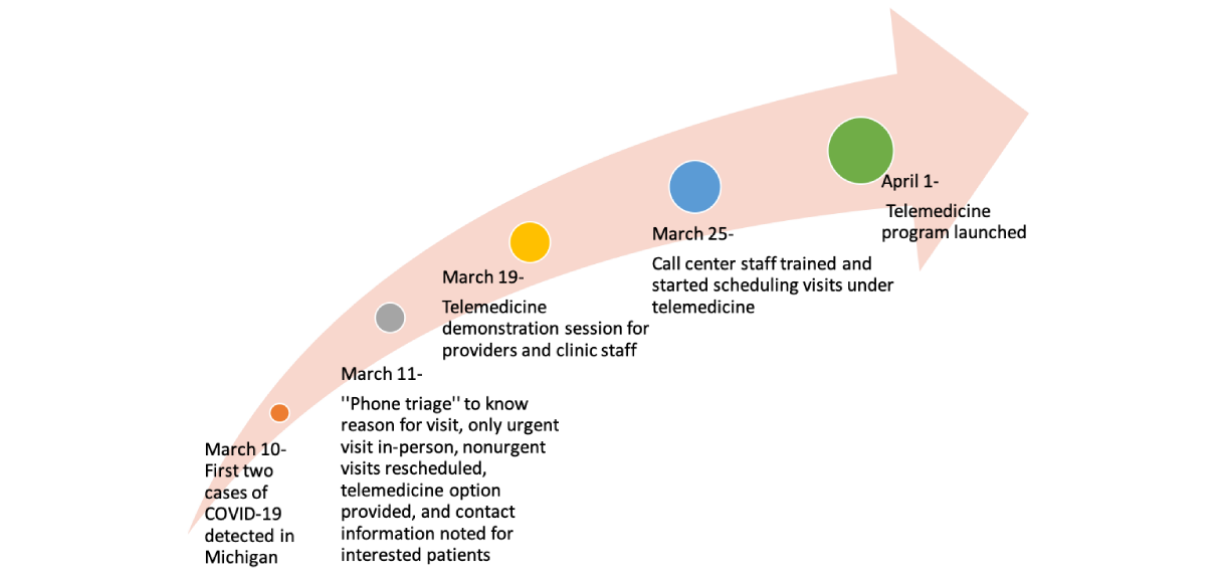
Figure 1. Ambulatory telemedicine clinic